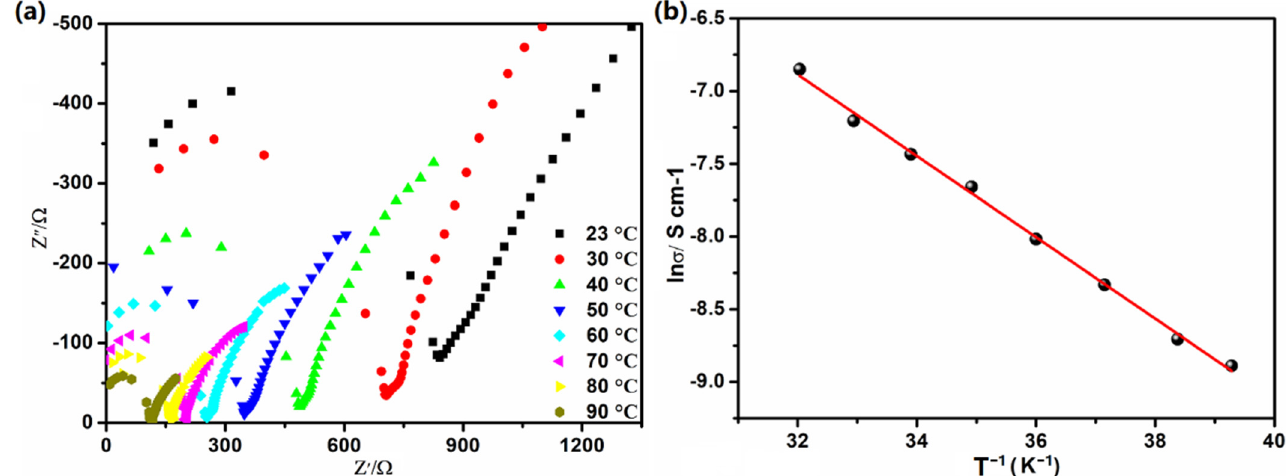
Figure 2. ( a ) The A C impedance plots and ( b ) an Arrhenius-type plot of compound 1 at different temperatures in water.